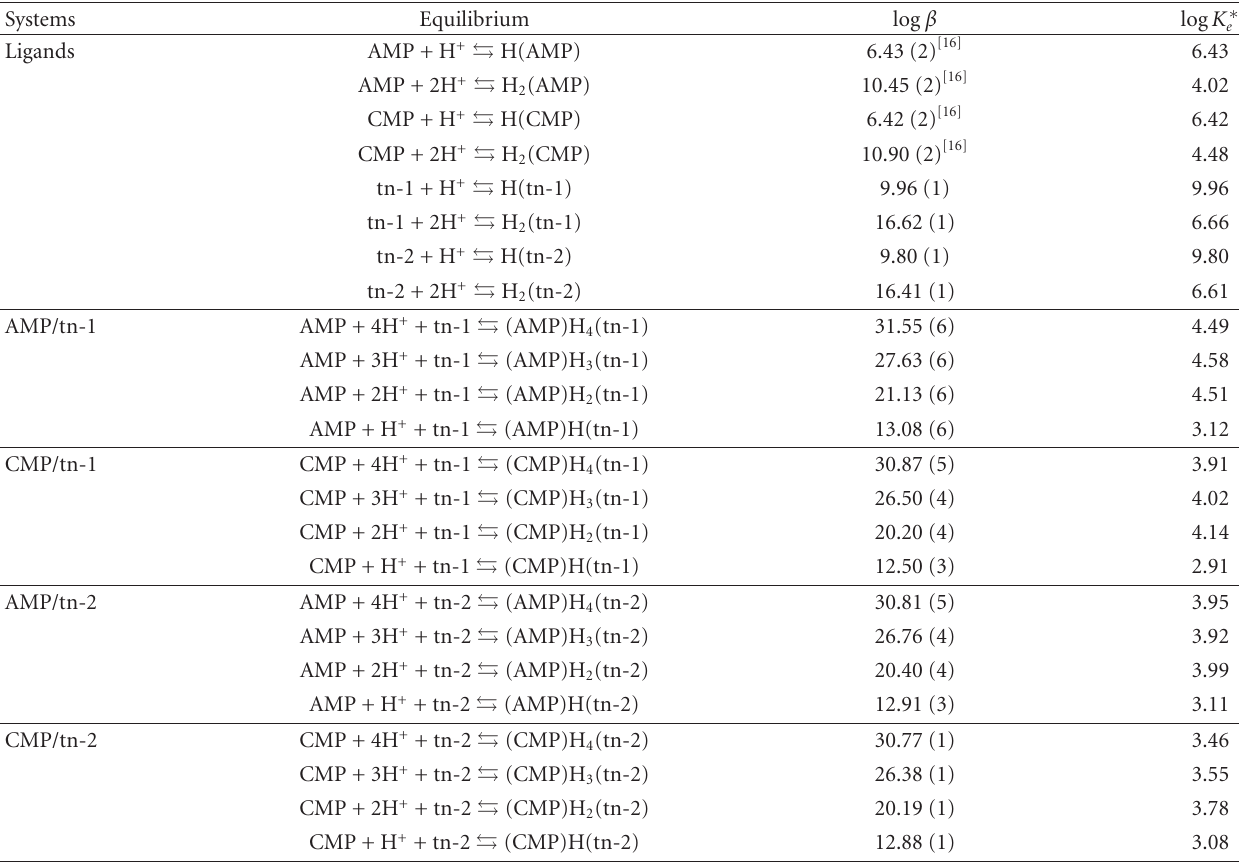
Table 1: Overall protonation constants, overall stability constants (log β ), and equilibrium constants (log K e ) of adducts formation in AMP/tn-1, AMP/tn-2, CMP/tn-1, and CMP)/tn-2